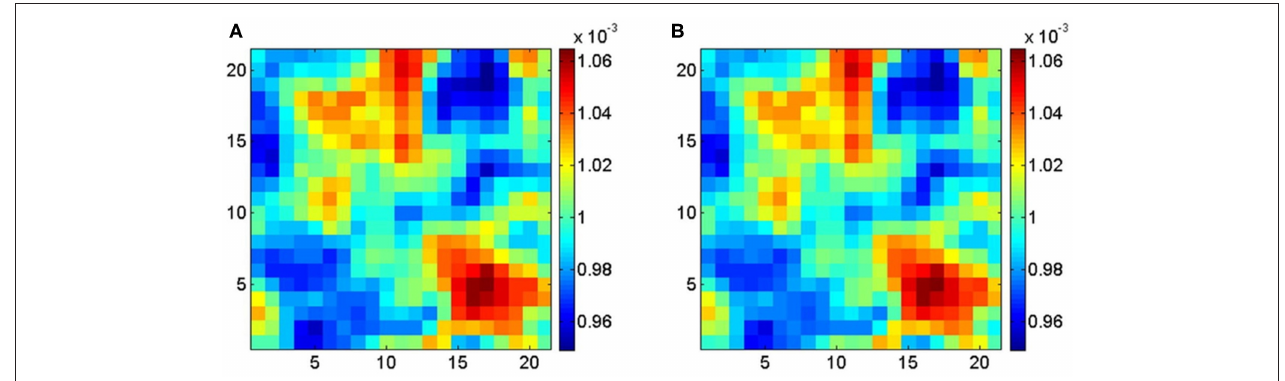
FIGURE 4 | Comparison of strain field distributions within middle slices for a low elastic anisotropy cubic polycrystalline microstructure (21 × 21 × 21 pixels) obtained from predictions performed with (A) materials knowledge system (MKS) and (B) finite element method (FEM). Reprinted from Yabansu and Kalidindi (2015), Copyright (2015), with permission from